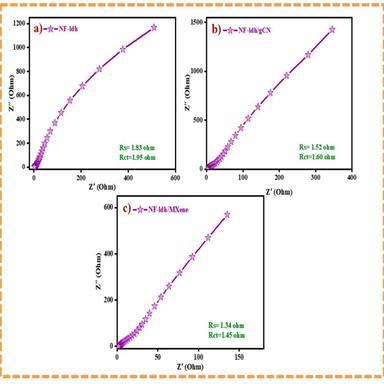
Electrochemical impedance spectra of photocatalysts i.e. pristine LDH and its composites.